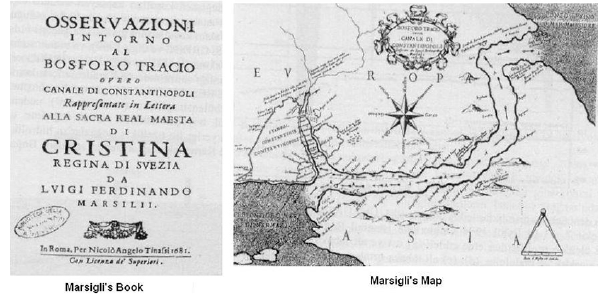
Figure 7. Marsigli’s book on Oceanographic studies and Map of the Bosphorus.